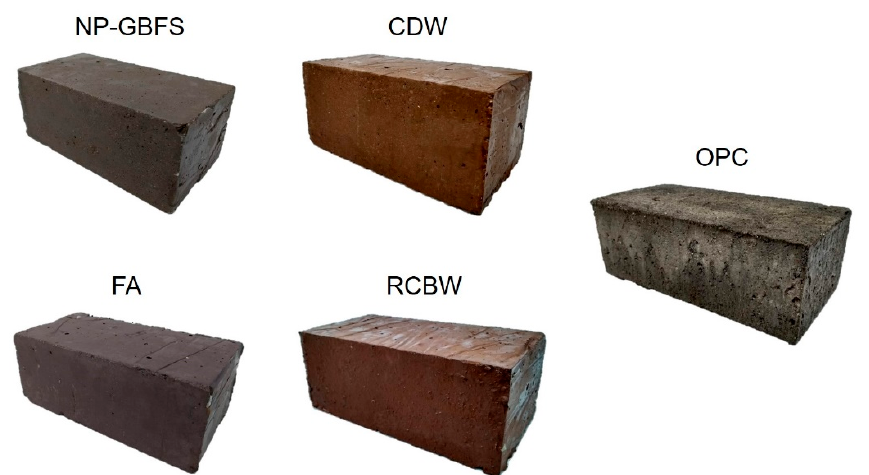
Figure 4. Blocks produced: alkali-activated (natural pozzolan–granulated blast furnace slag (NP– GBFS), fly ash (FA), construction and demolition waste (CDW), and red clay brick waste (RCBW)) and reference (OPC).